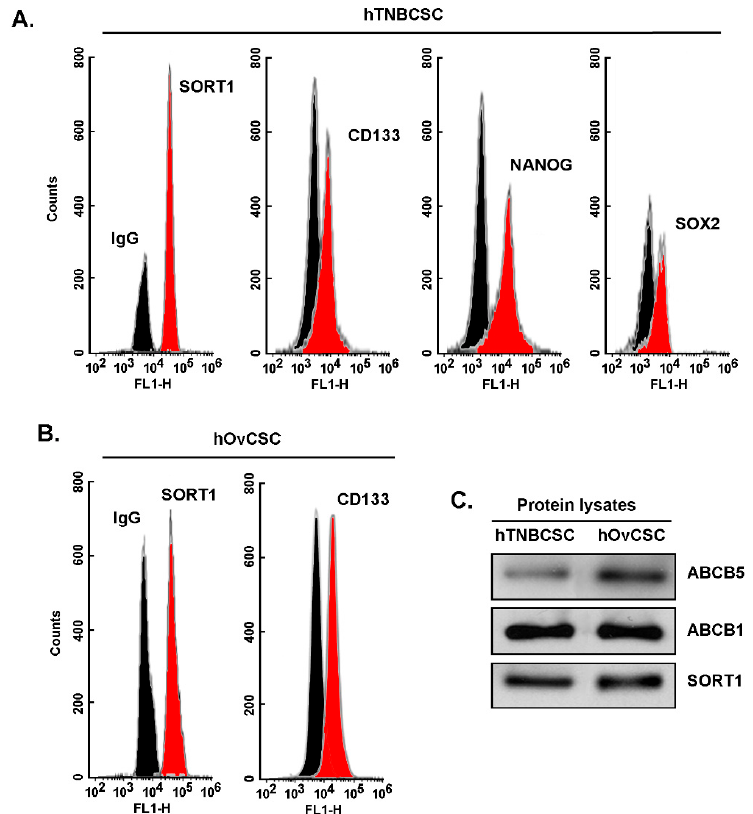
Figure 1. Immunophenotyping of SORT1 and CSC biomarkers expression in hTNBCSC and hOvCSC. Immunophenotyping was performed for ( A ) SORT1, CD133, NANOG and SOX2 in hTNBCSC, and for ( B ) SORT1 and CD133 in hOvCSC as described in the Methods section using flow cytometry (IgG is the control Ab isotype, black profile). ( C ) hTNBCSC and hOvCSC cell homogenates (20 µ g protein) were separated on a polyacrylamide gel and electrotransferred onto a polyvinylidene difluoride membrane. SORT1, ABCB1, and ABCB5 proteins were detected on the membranes